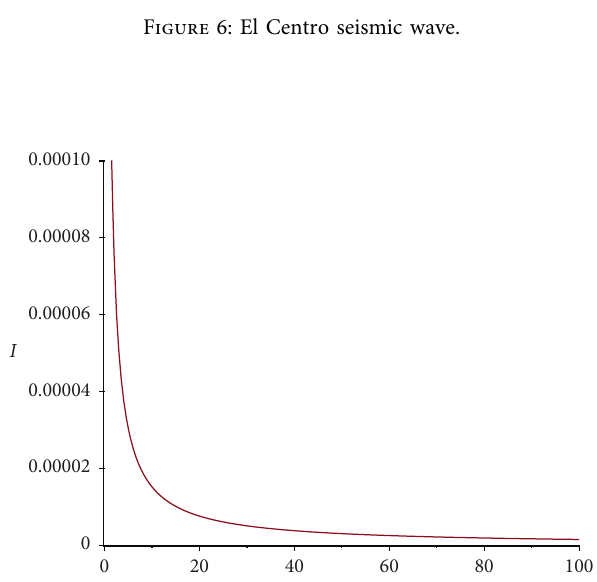
Figure 6: El Centro seismic wave.